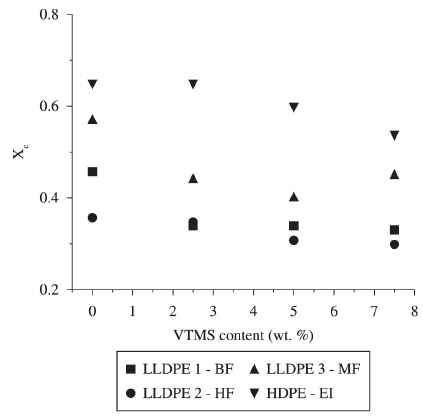
Figure 4. Degree of crystallinity of crosslinked samples.